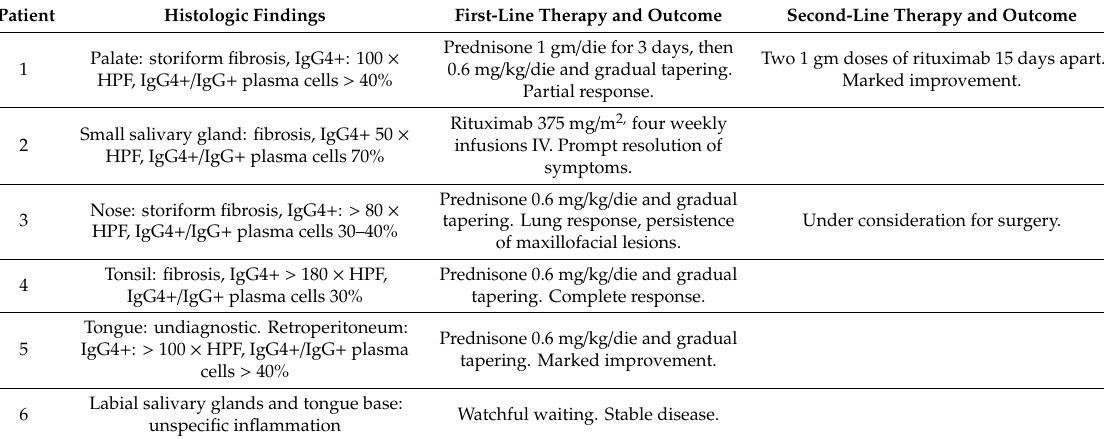
Table 2. Histologic findings, therapies and